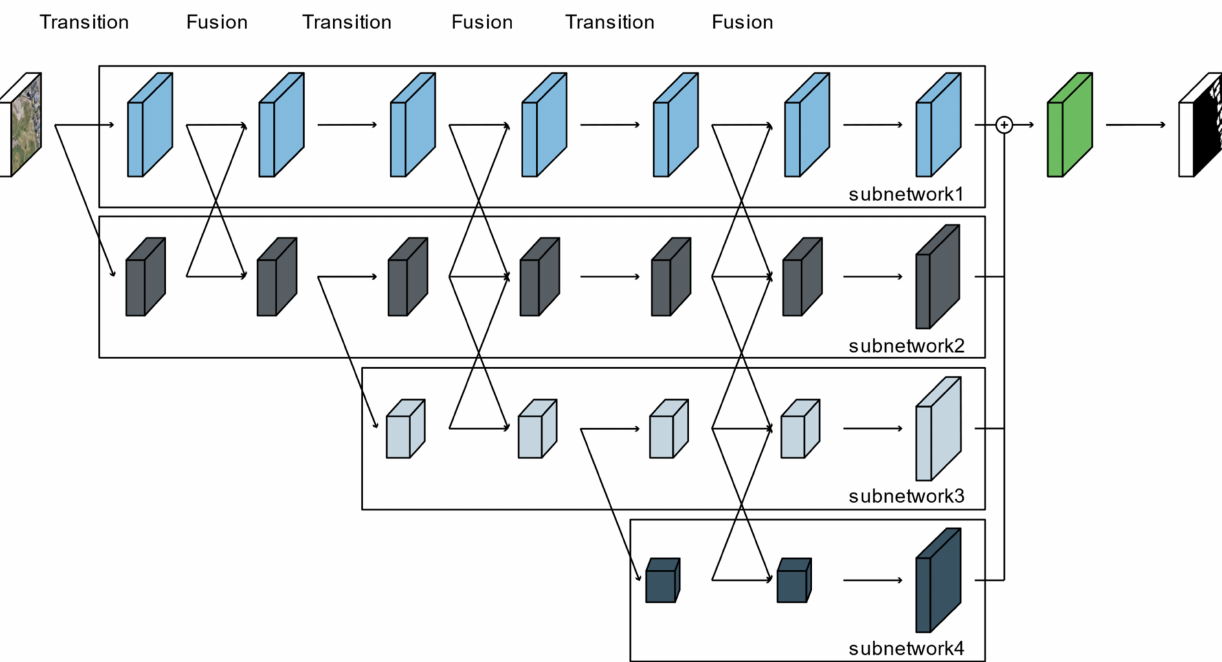
Figure 1. Architecture of the HRNet-v2